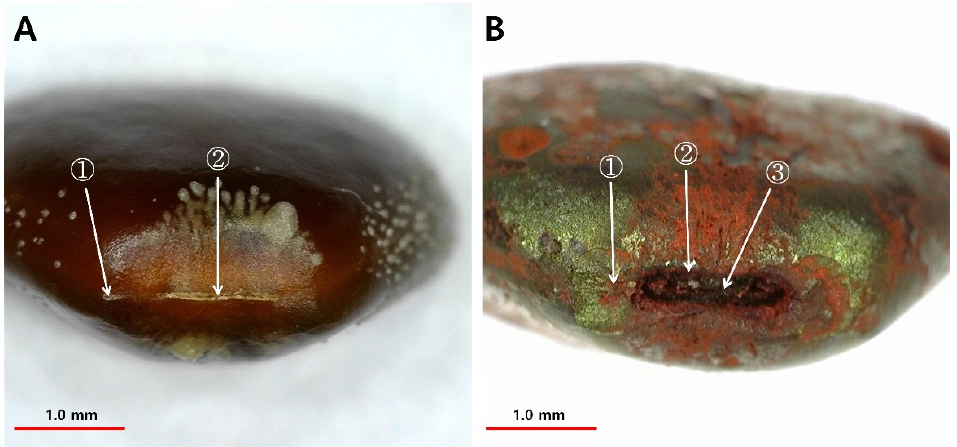
Figure 2. Water gap opening of Hovenia dulcis seeds after 24 h in water after ( A ) no treatment and ( B ) sulfuric acid treatment for 1 h. Arrows ① , ② , and ③ indicate micropyle, hilum, and hilar fis- sure, respectively.